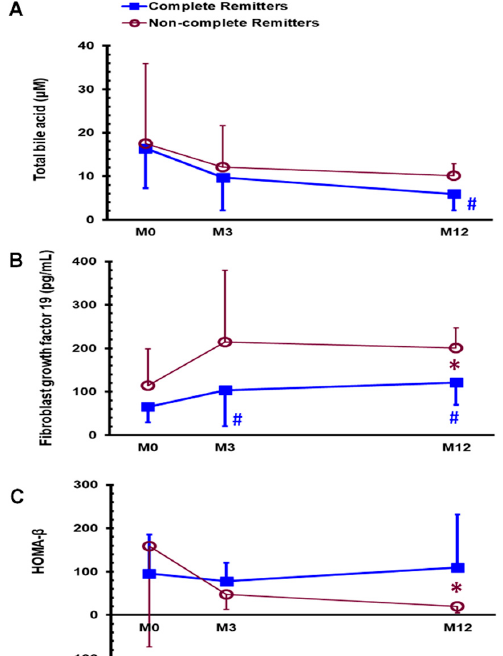
Figure 3. Serum levels of total bile acid ( A ) and fibroblast growth factor 19 ( B ) and HOMA- β index ( C ) in the DM-CR and DM-non-CR groups before (M0) and 3 months (M3) and 1 year (M12) after sleeve gastrectomy. * p < 0.05 compared between the DM-CR and DM-non-CR groups, # p < 0.05 compared with MDM-CR, complete remitters of diabetes mellitus; DM-non-CR, non-complete remitters of diabetes mellitus; HOMA- β , homeostasis model assessment- β .